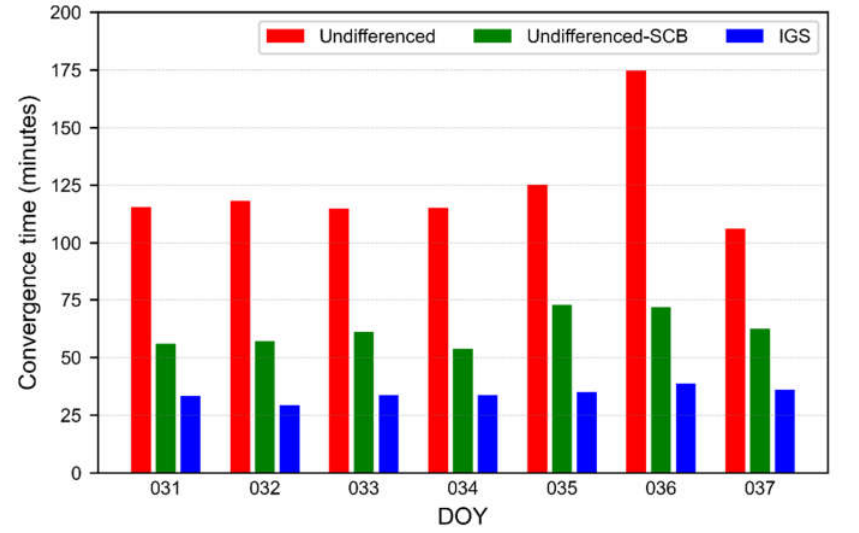
Figure 13. The mean convergence time for various PPP solutions from DOY 031 to